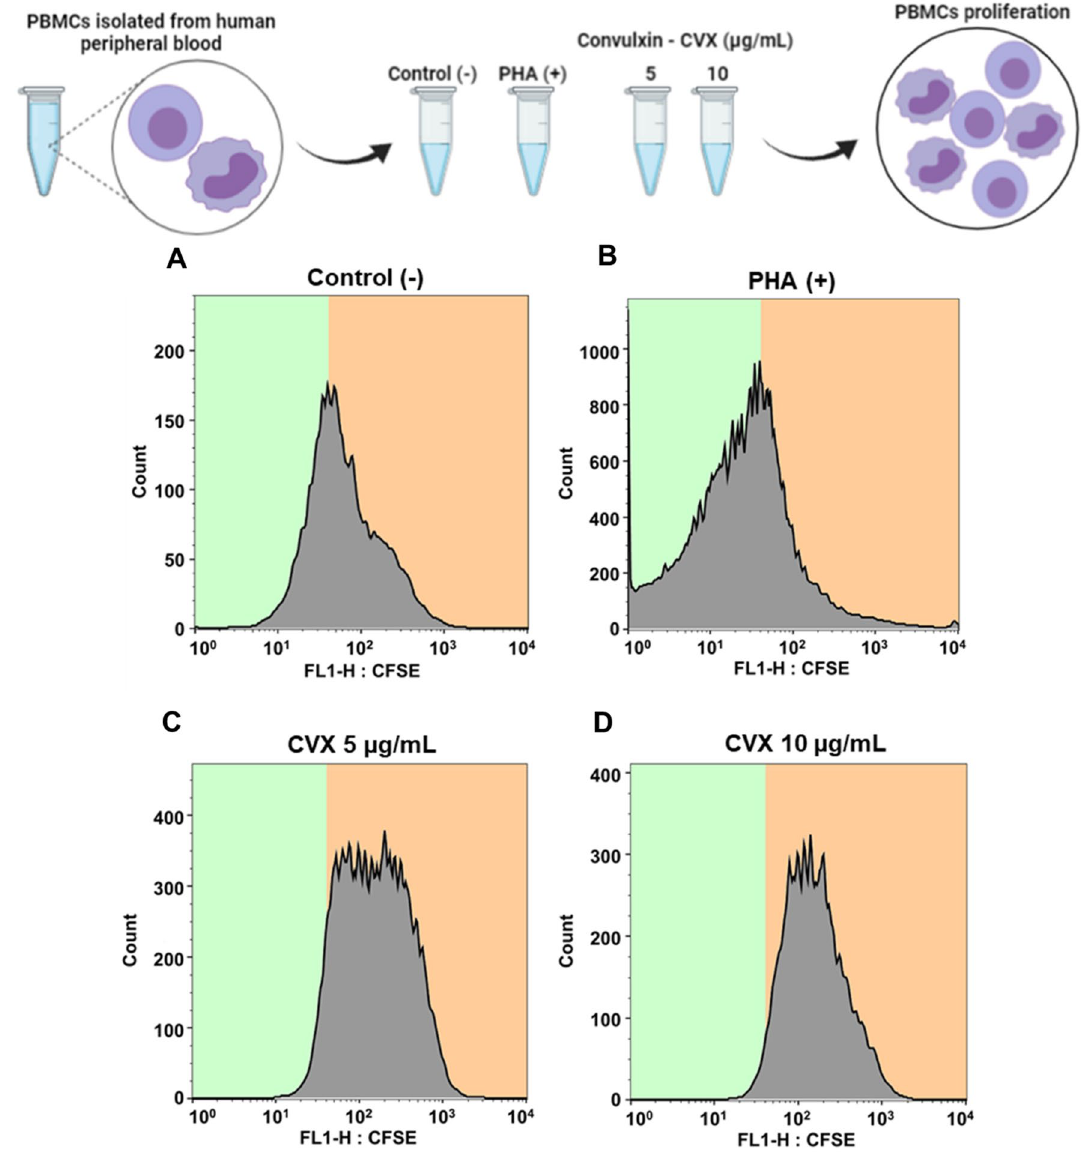
Figure 2. Cell proliferation of PBMCs in the presence of Convulxin. CFSE labelling of 2 × 10 5 PBMCs proliferation followed by stimulation with RPMI (negative control) ( A ), PHA (5 µg/mL; positive control) ( B ) or CVX (5 and 10 μg/mL) ( C , D ) for 72 h and were analyzed in FACScan. The results were expressed as counts in histograms and represent the mean ± S.E.M of 3